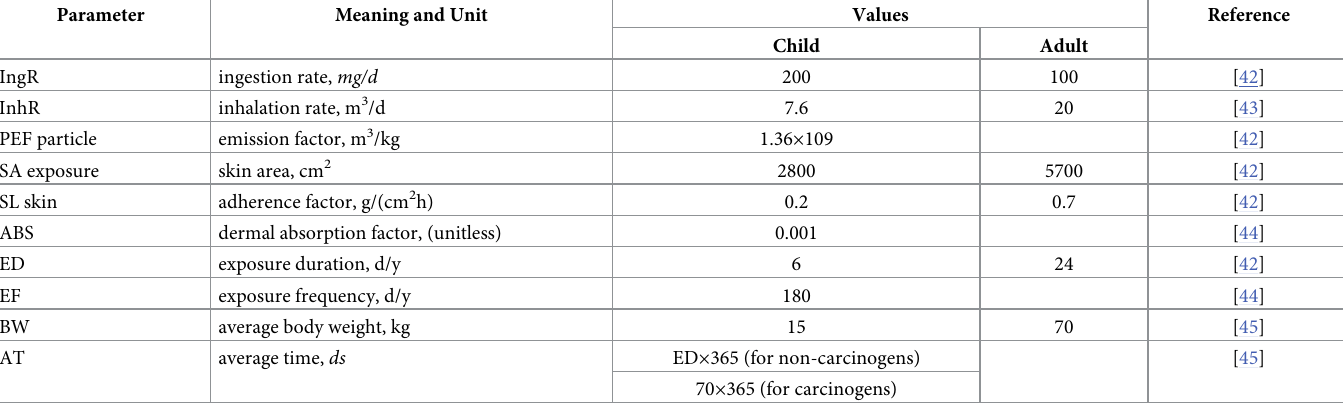
Table 1. Parameter meaning and value of daily dose model of heavy metals in urban surface dusts.